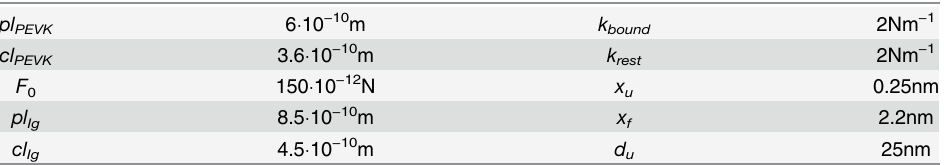
Table 1. Mechanical model parameters [16, 36, 41, 42].